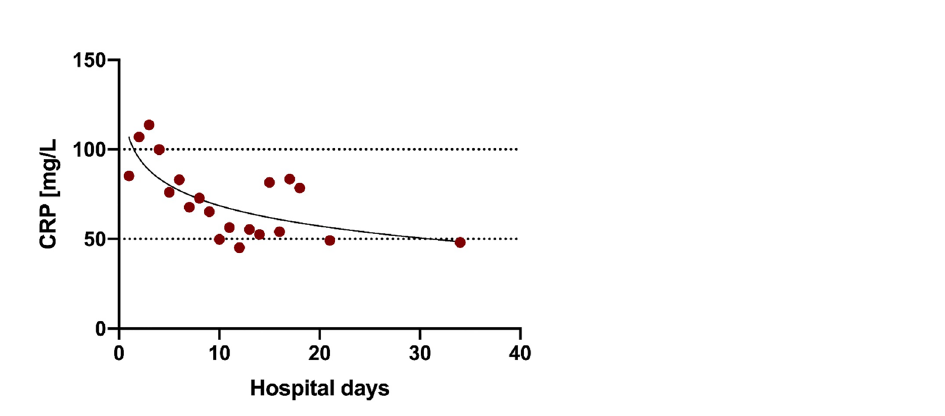
Figure 2. Example for the long-lasting elevation of inflammatory parameters in COVID-19 pneumonia. Mean of CRP (C reactive protein, red) in mg/L for complete cohort by hospital